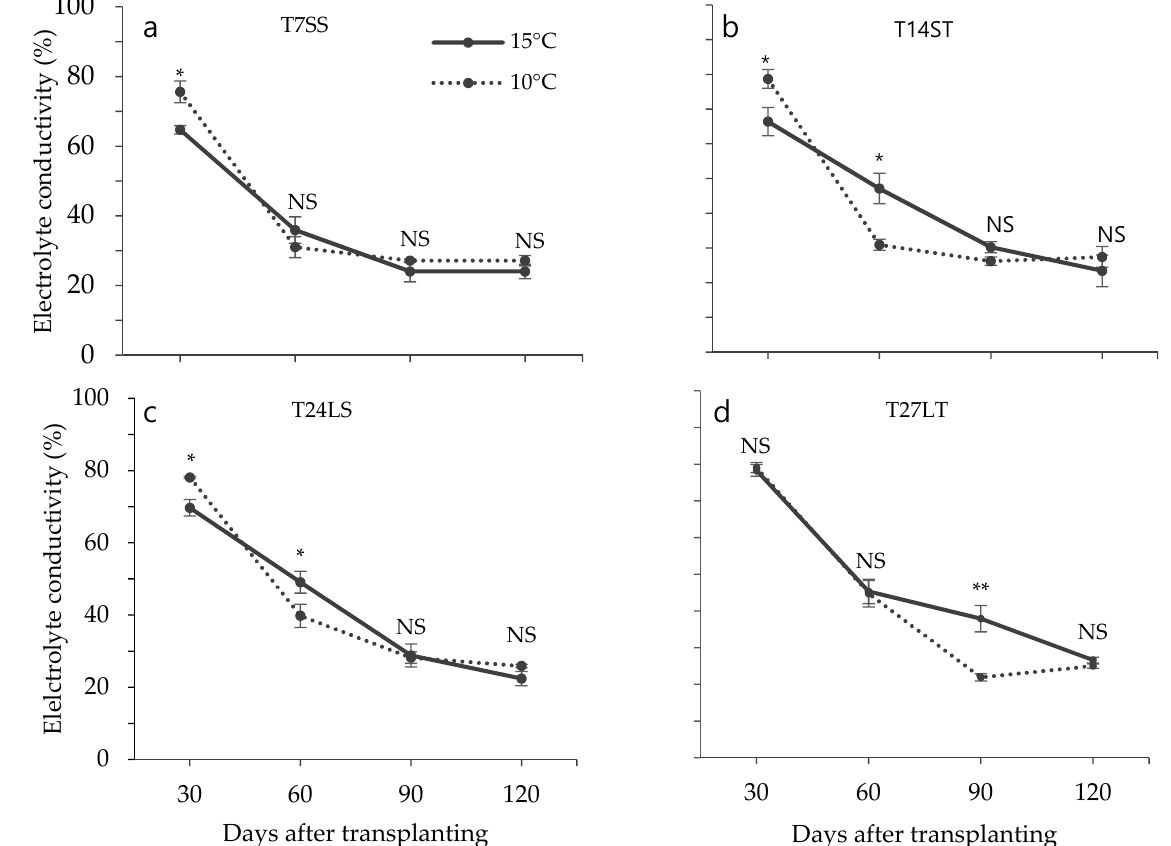
Figure 6. Changes in electrolyte conductivity in the leaves of cherry-type accessions T7SS ( a ) and T14ST ( b ), and of large-fruit-type accessions T24LS ( c ) and T27LT ( d ) grown in 10 and 15 °C. SS: small sensitive, ST: small tolerant, LS: large sensitive and LT: large tolerant. Values are means ± SD (n = 3). NS, * and ** indicate not significant and significant at the p ≤ 0.05 and p ≤ 0.01 levels in t -test, respectively.